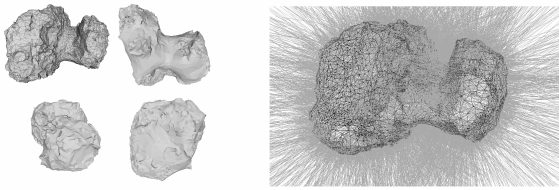
Figure 1. The 3D model of the 67P comet nucleus: the polygonal par- tition, the surface relief, and the cloud of normals to the partition